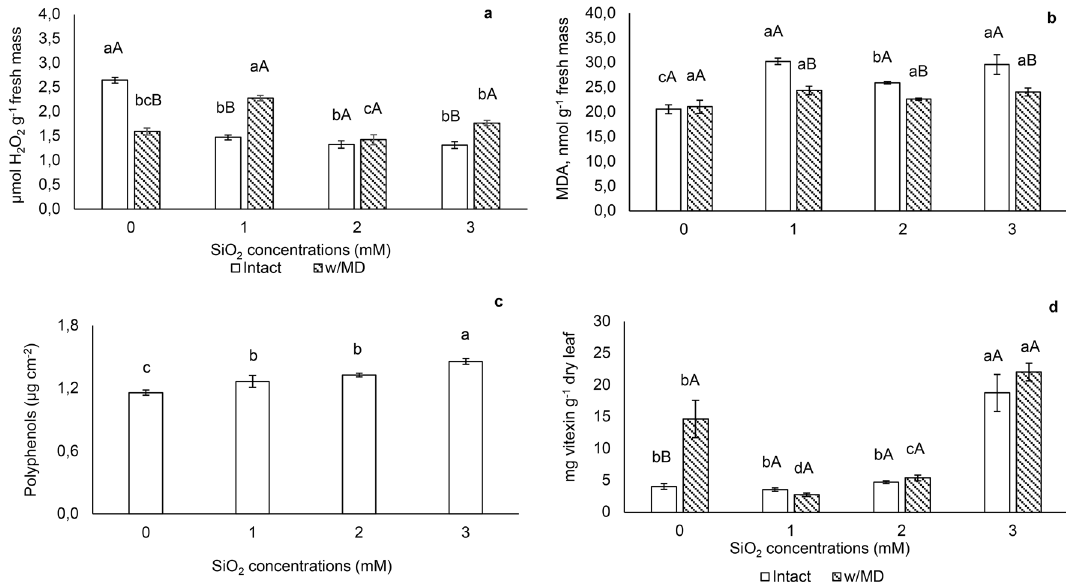
Figure 3. ( a ) Hydrogen peroxide, ( b ) lipid peroxidation, ( c ) polyphenols and ( d ) vitexin concentration. H 2 O 2 p < 0.05; lipid peroxidation expressed by the formation of malonaldehyde (MDA) p < 0.05; polyphenols p < 0.01; vitexin p < 0.01 in Passiflora incarnata L. with mechanical damage (w/MD) and without mechanical damage (intact), subjected to SiO 2 variations. Values corresponding to the averages ± SE. Capital letters compare plants with and without mechanical damage and lower letters compare SiO 2 variations. Polyphenols results were significant only for SiO 2 variations. Other results were significant for the interaction between SiO 2 variations and the presence/absence of mechanical damage.